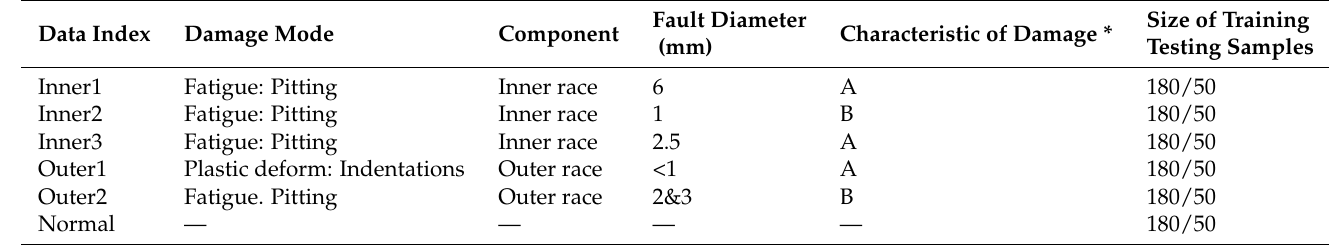
Table 7. The rolling bearing operation conditions of all kinds. (* A: single point without repetitive damage. B: single point damage with random